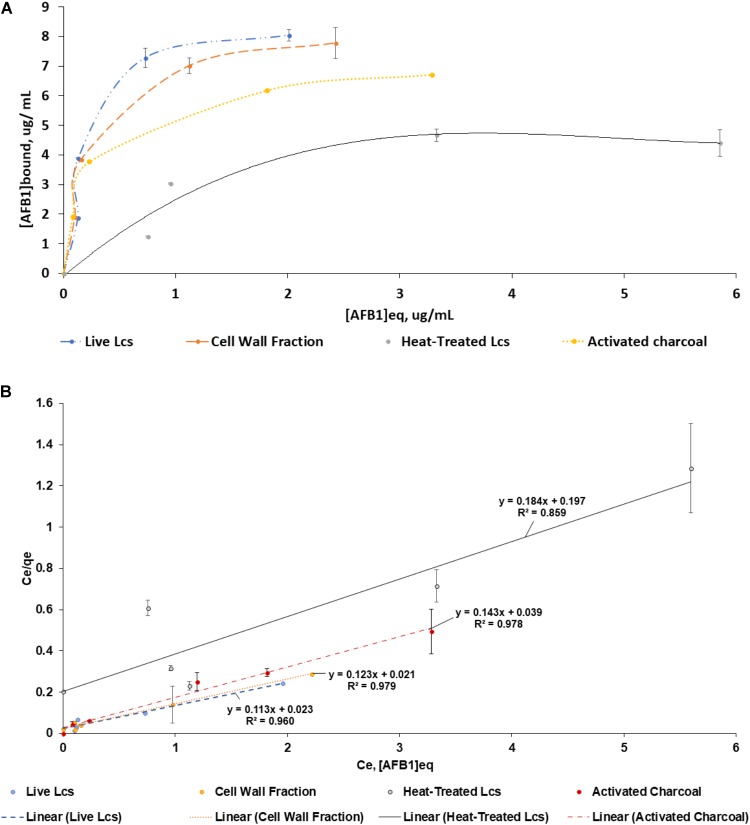
Adsorption isotherms of AFB1 by Lcs cell components. Aliquots of 1 ml of 109 cells (Lcs live cells; heat-treated cell; cell wall component) and 2 μg of activated charcoal were suspended in PBS in the presence of AFB1 at the following concentrations: 2, 4, 6, 8, and 10 μg/mL. Then, the bacteria were incubated for 1 h at 37°C and pelleted by centrifugation. The supernatant was collected for free AFB1 analysis by ELISA. AFB1 bound to cells was calculated as the difference between the total AFB1 and the amount of free AFB1. (A) Saturation curve. (B) Ce vs. Ce/Qe of the same data as (A). Data are means from triplicate experiments (error bars indicate mean ± SD).